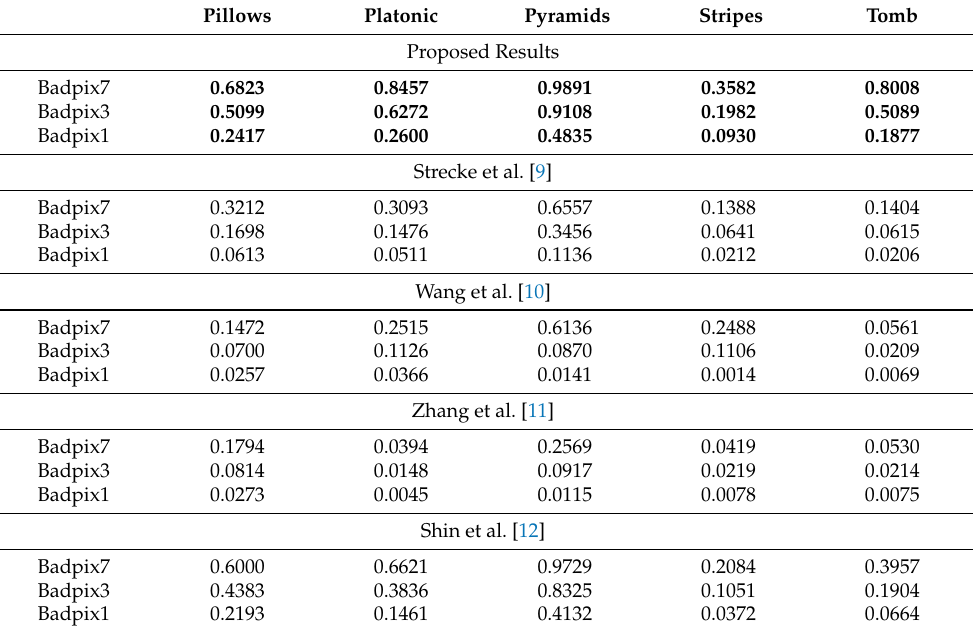
Table 6. Quantitative depth map comparison for synthetic data to ground truth for different algo- rithms for noisy